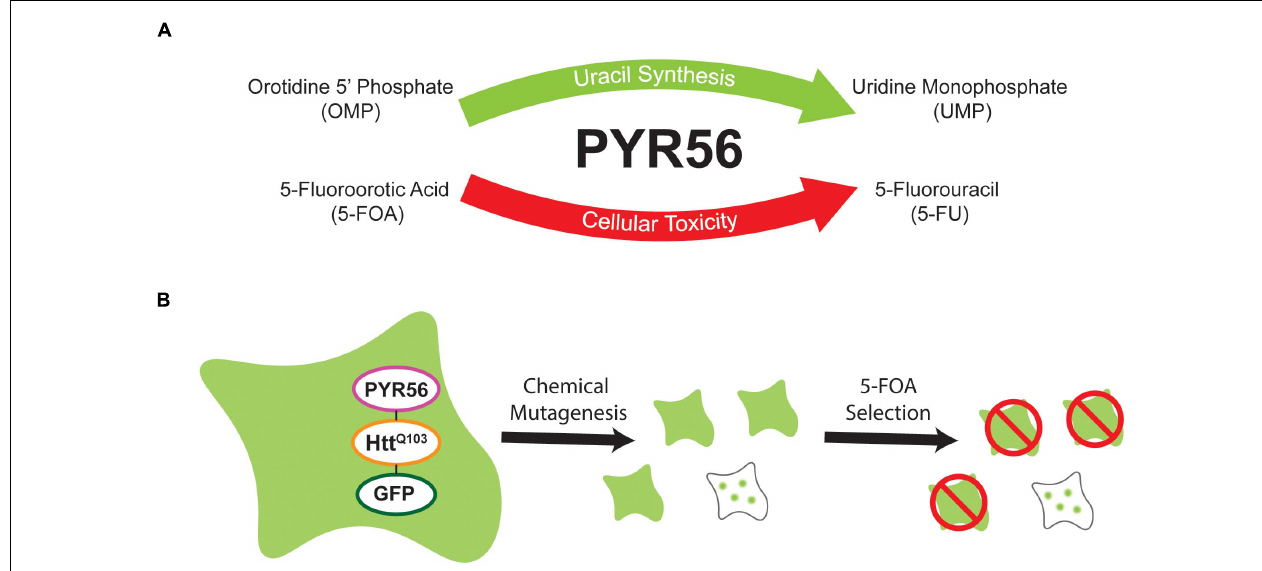
FIGURE 1 | Overview of selection strategy. (A) The Dictyostelium UMP synthase, Pyr56, is an essential component of the de novo uracil synthesis pathway. However, Pyr56 also catalyzes the conversion of the prodrug 5-FOA to toxic 5-FU, leading to cell death. (B) A fusion protein containing the UMP synthase Pyr56 fused to a polyglutamine-expanded fragment of Htt exon 1 and a fluorescent reporter GFP will remain soluble in pyr56- KO cells. Following chemical mutagenesis, cells which lose function of a polyglutamine aggregation suppressing factor will demonstrate aggregation of the fusion protein. Sequestration of Pyr56 activity by protein aggregation confers resistance to 5-FOA, allowing for selection of polyQ aggregation